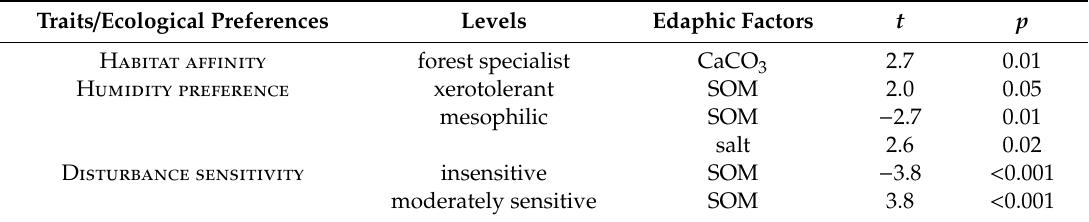
Table 3. Results of the general linear mixed models showing significant relationships between functional trait levels and edaphic factors. SOM: soil organic